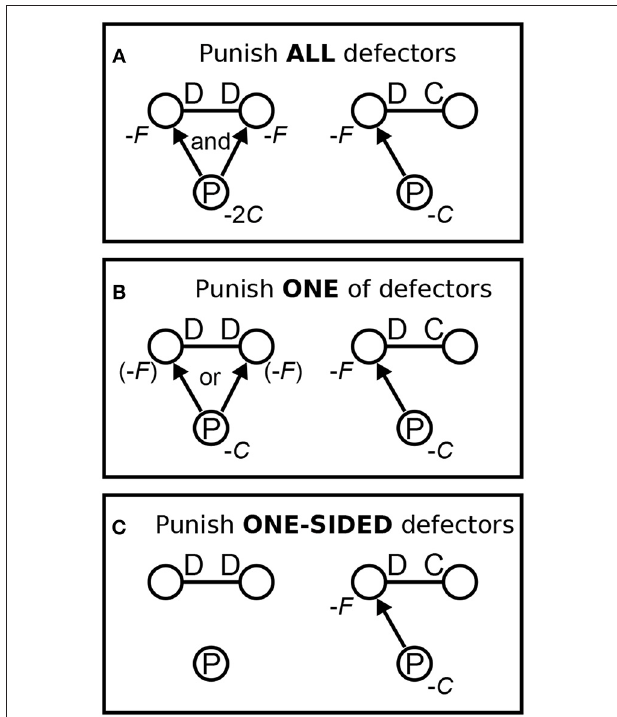
FIGURE 2 | Three variants of third-party punishment. Blank circles represent players and those with “P” represent punishers as observers. Each line connecting blank circles, above which “D D” or “D C” is attached, represents mutual defection or one-sided defection in a game, respectively. Arrows represent that punishment is executed. (A) ALL defectors are punished: in case of mutual defection, the punisher pays cost 2 C and each of the two defectors pays fine F . (B) Only ONE of defectors is punished: in case of mutual defection, the punisher pays cost C and one of the two defectors, selected at random, pays fine F . (C) Only a ONE-SIDED defector is punished: the punisher does not care about mutual defection. In all the three variants, the punisher pays cost C and the defector pays fine F in case of one-sided